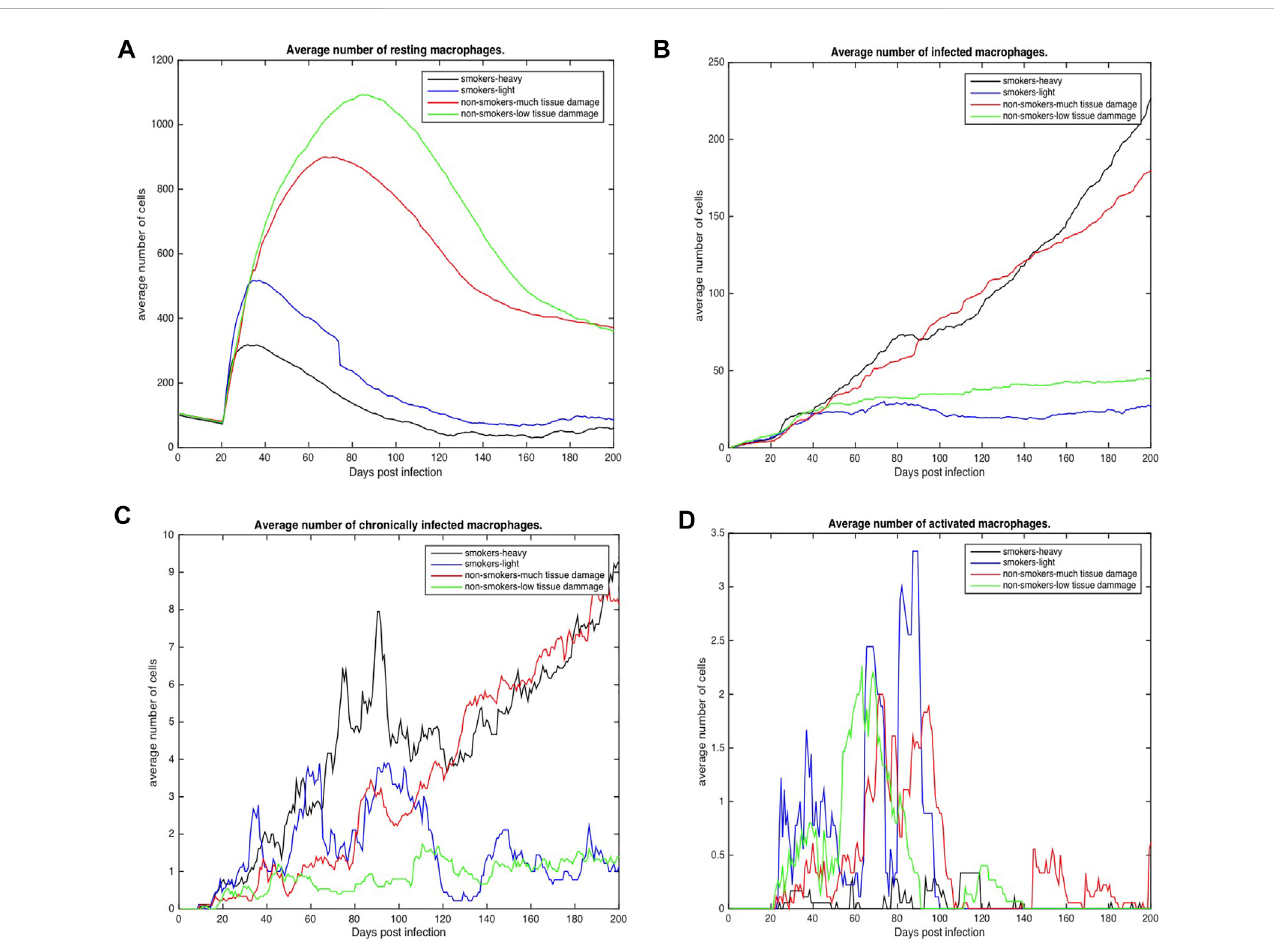
FIGURE 4 Number of macrophages involved in the immune response to Mtb for COPD non-smokers and smokers both heavy and light. Values represent the average for each COPD group. (A) Average number of resting macrophages across all categories (B) Average number of infected macrophages across all categories (C) Averagenumberofchronicallyinfectedmacrophagesacrossallcategories (D)